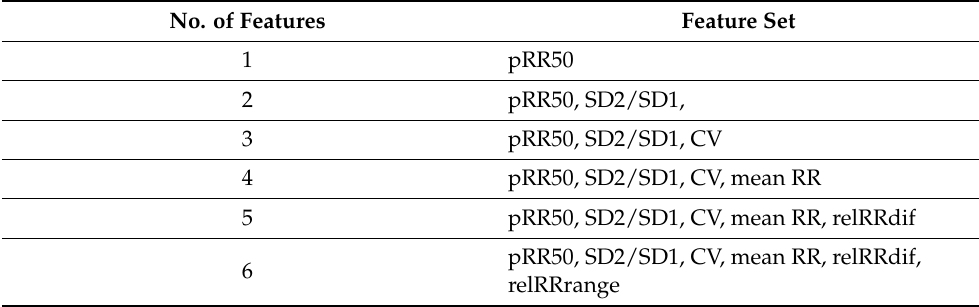
Figure 7. Specificity of AF detection for different classifiers with sets of one to six features (orange points — blindfold validation, blue points — 5-fold cross-validation). DT — decision tree, KNN — K nearest neighbors, SVM linear — support vector machine with linear kernel, SVM RBF — support vector machine with radial basis function kernel, ADA—Ada Boost, RF—random forest, ANN—artificial neural network.